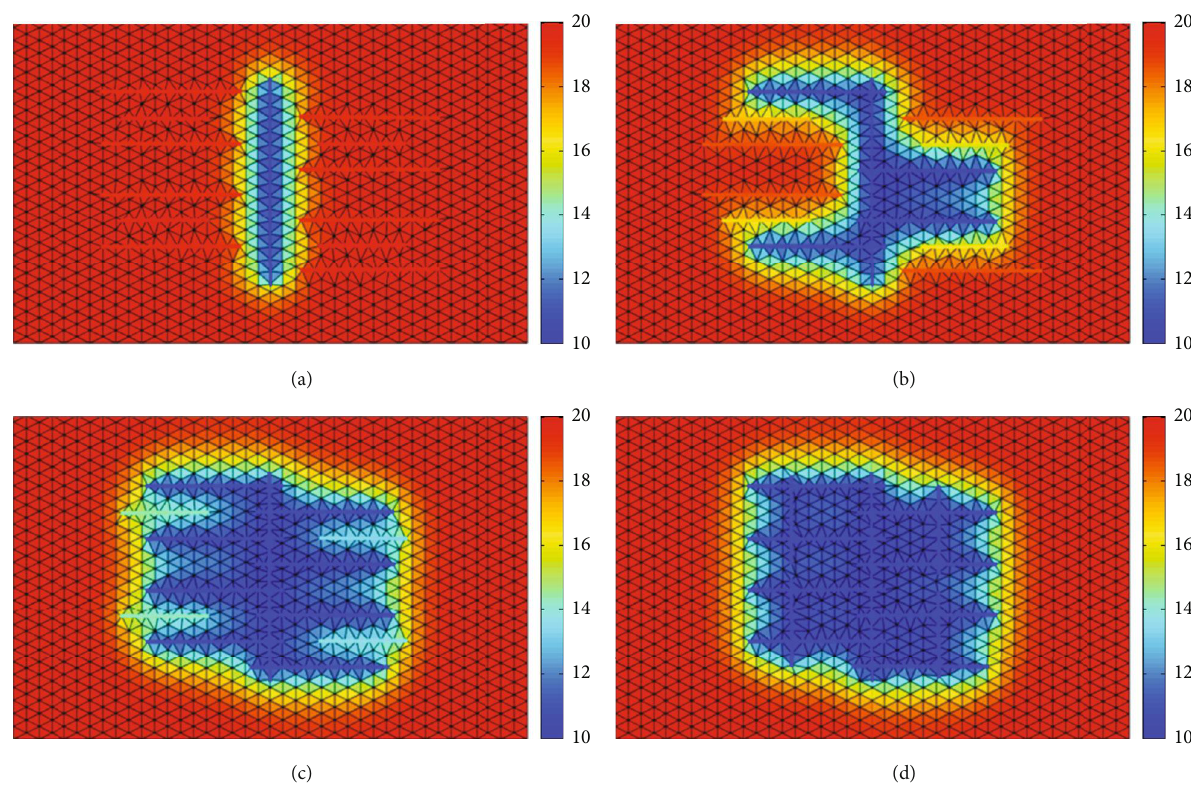
Figure 8: Reservoir pressure pro fi les at t = 200 days: (a) FD = 0 : 05 ; (b) FD = 0 : 07 ; (c) FD = 0 : 09 ; (d) FD = 0 : 11 .